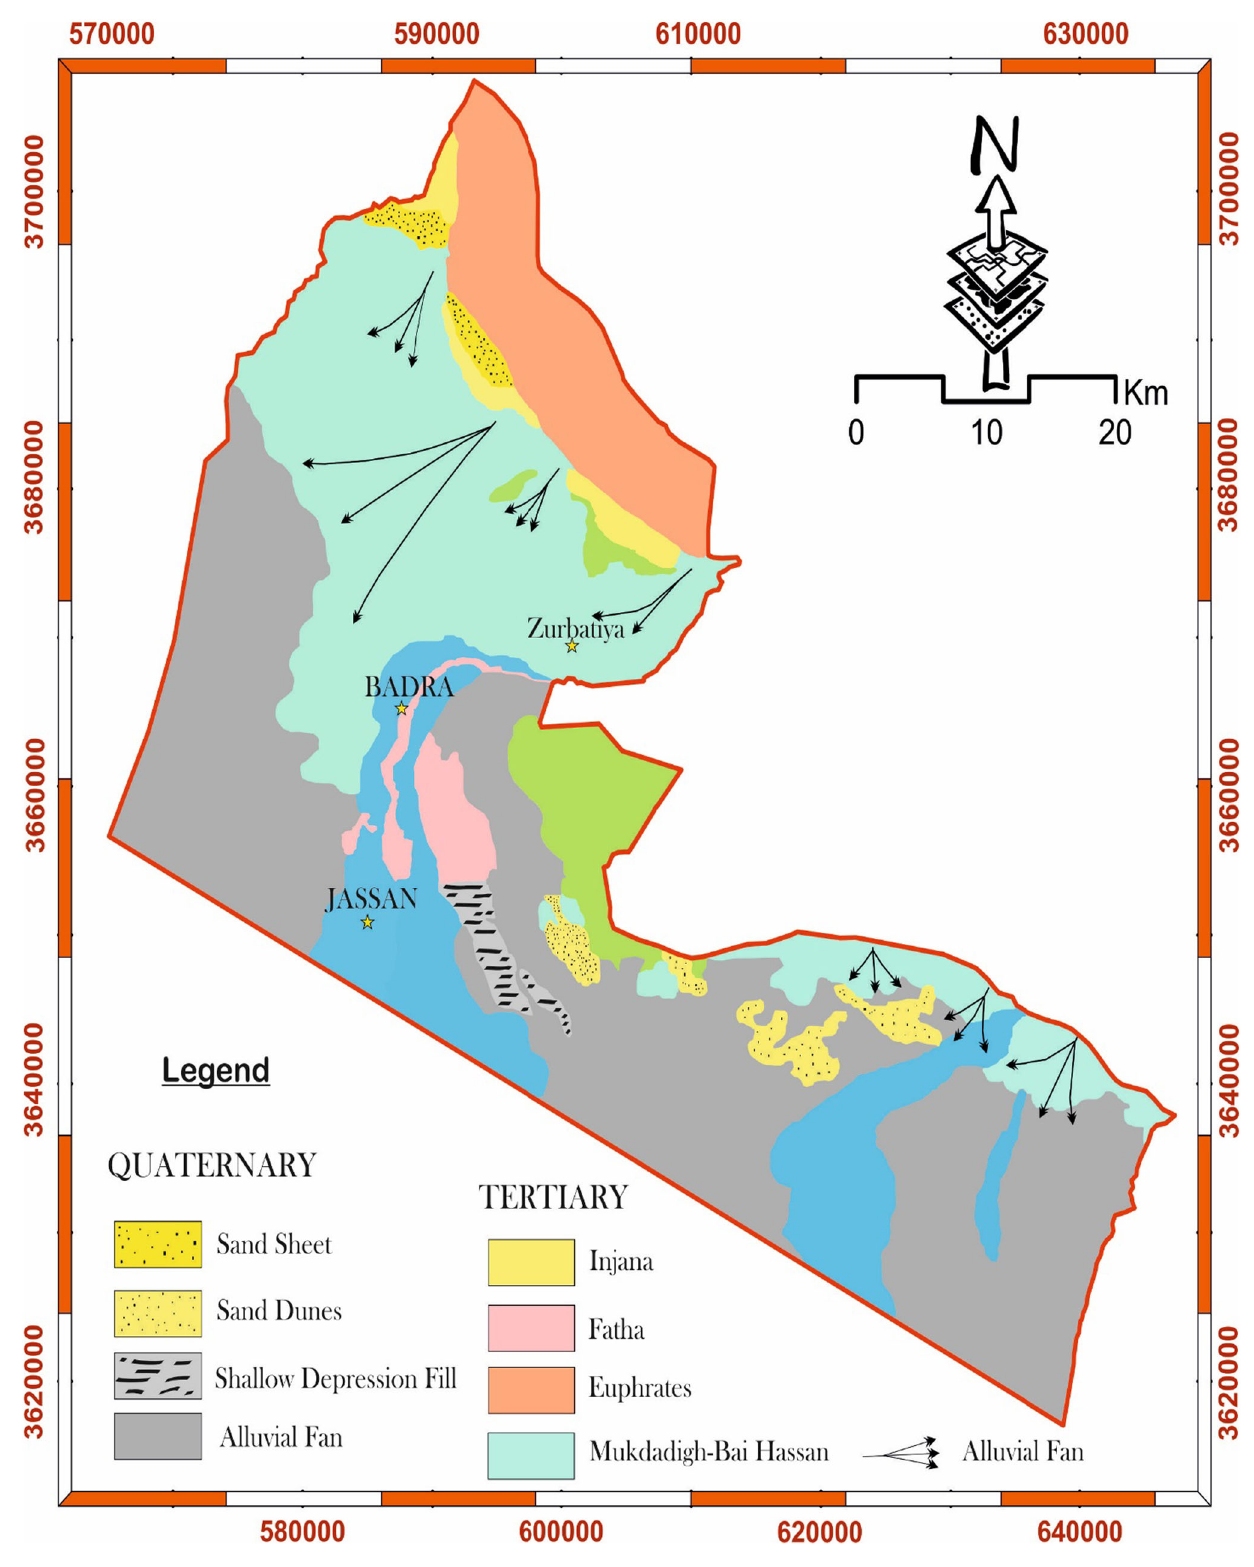
Fig. 3 Geological map of the study